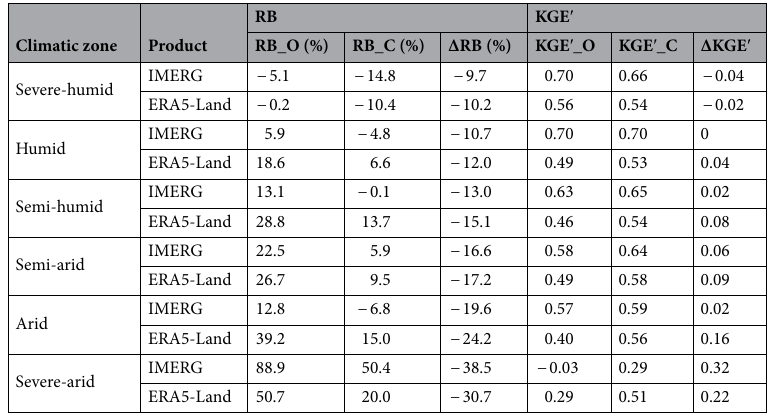
Table 4. Overall continuous metrics for IMERG and ERA5-Land over the different climatic zones.